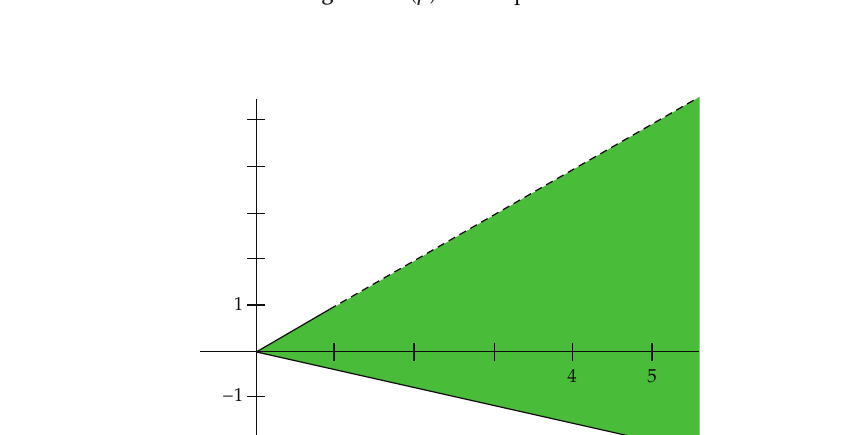
Figure 7: B (cid:2) p (cid:3) —Example 3.14.